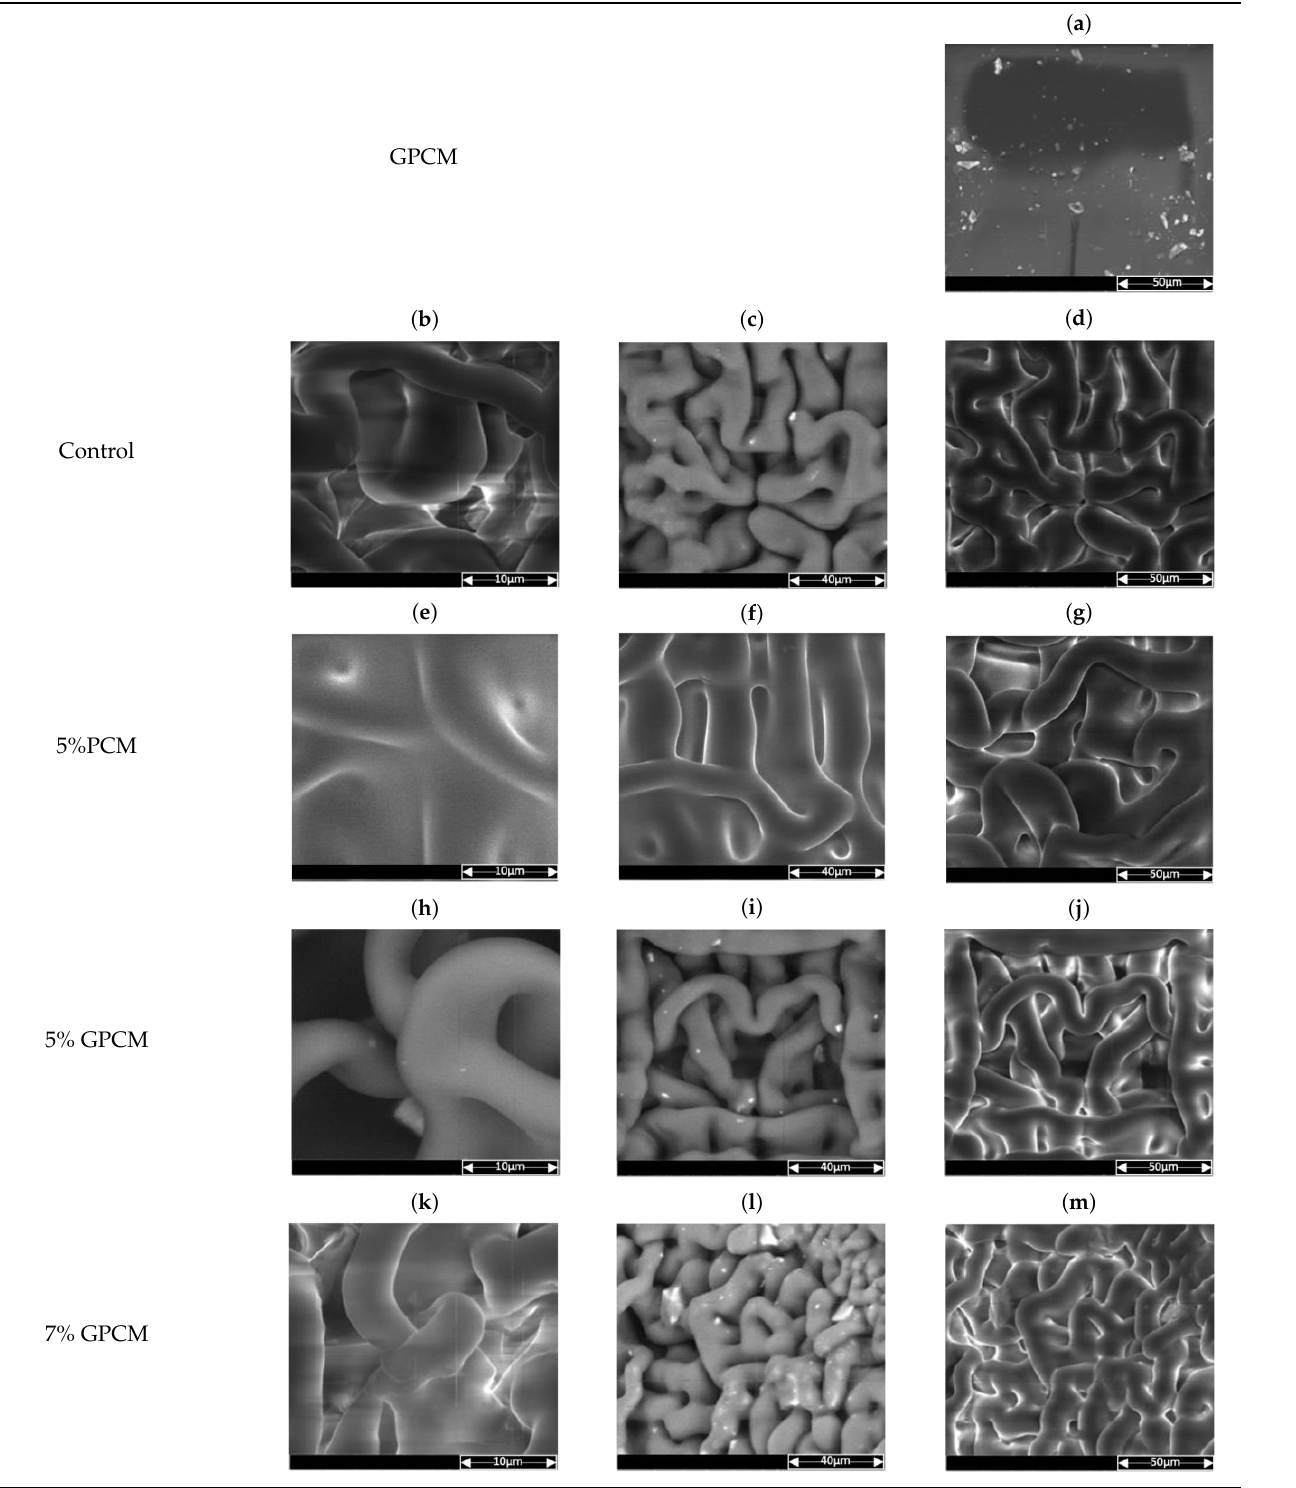
Table 6. ESEM observations for all tested binders .